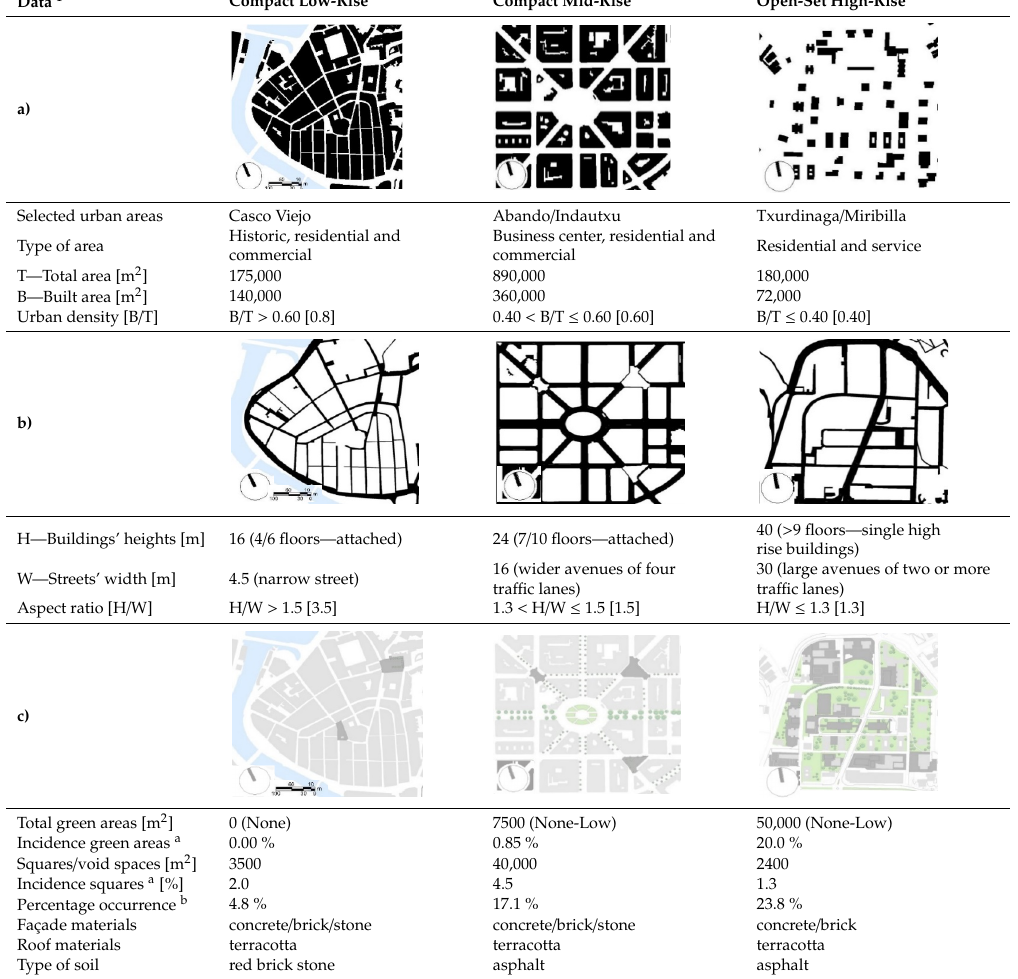
Table 1. Analysis of the current situation of the selected urban case study areas. Compact Low-Rise Compact Mid-Rise Open-Set Data